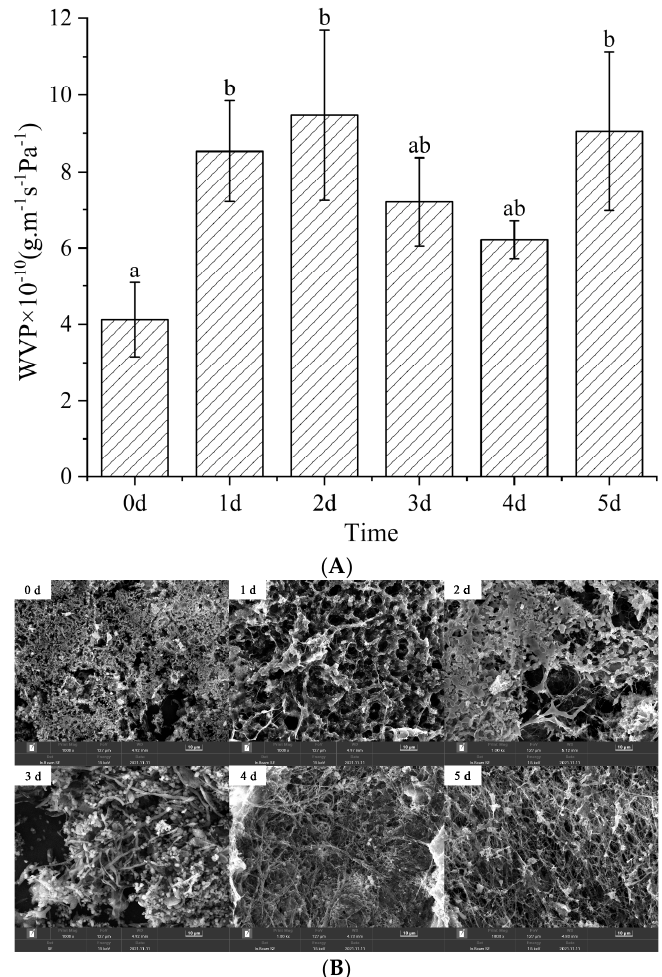
Figure 11. (A). Water vapor permeability of gelatin/zein/glucose nanofiber films after Maillard reactions conducted at 60 °C and 50% RH for 0~5 days (values with different superscript letters are significantly different, P < 0.05). (B). SEM images of gelatin/zein/glucose nanofiber films after immersion in water for 2 months.